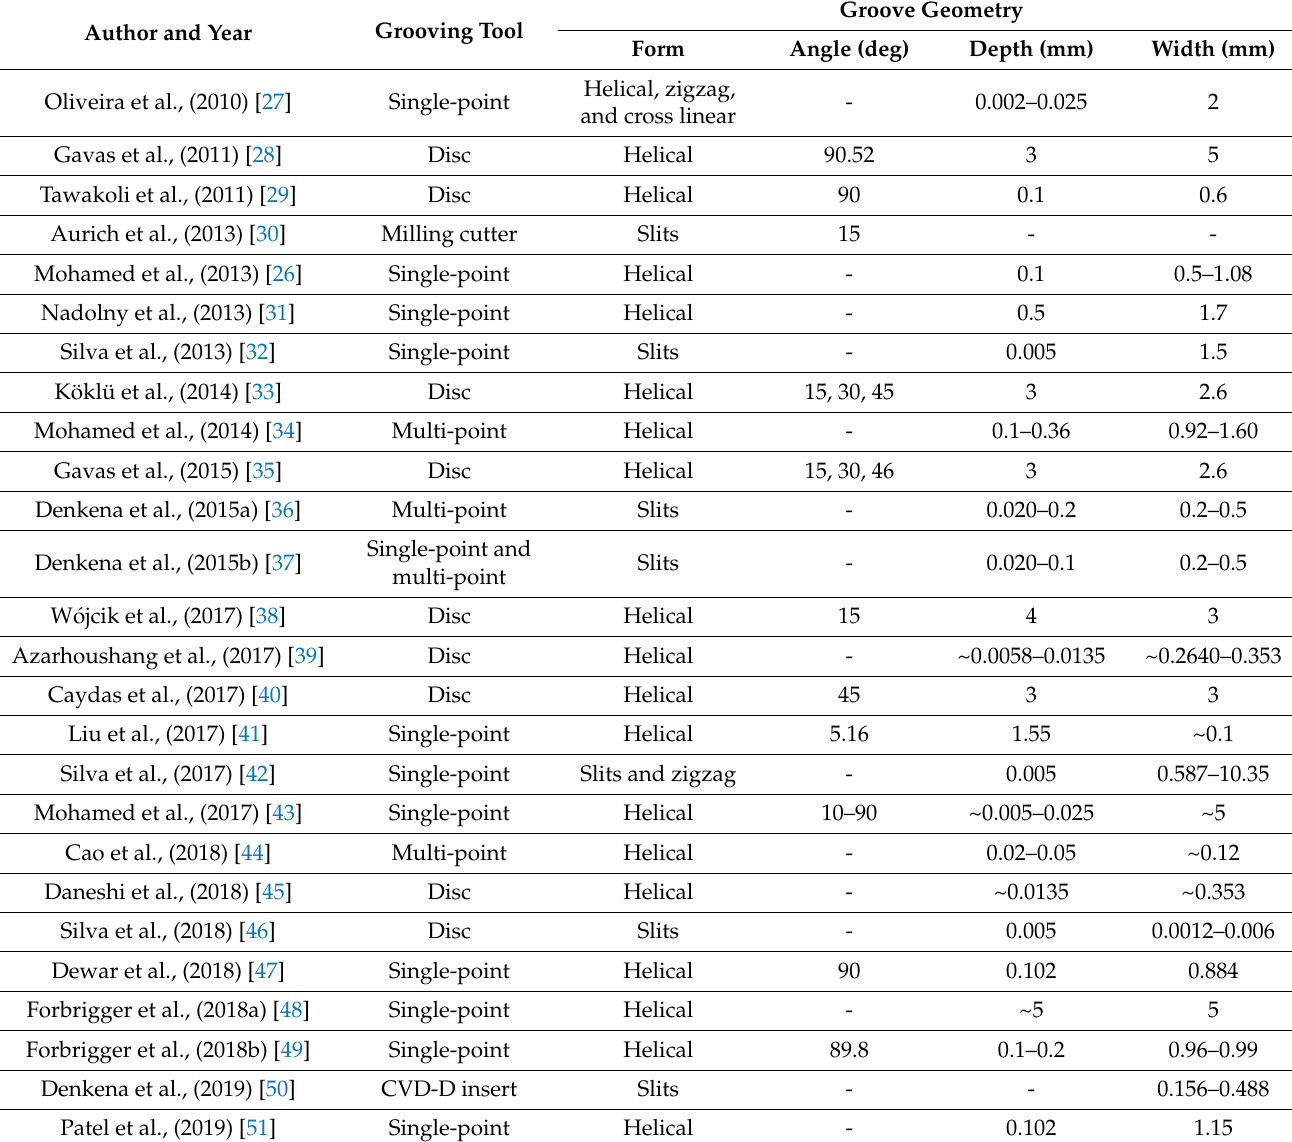
Table 2. Grooving tools and machined groove geometries and